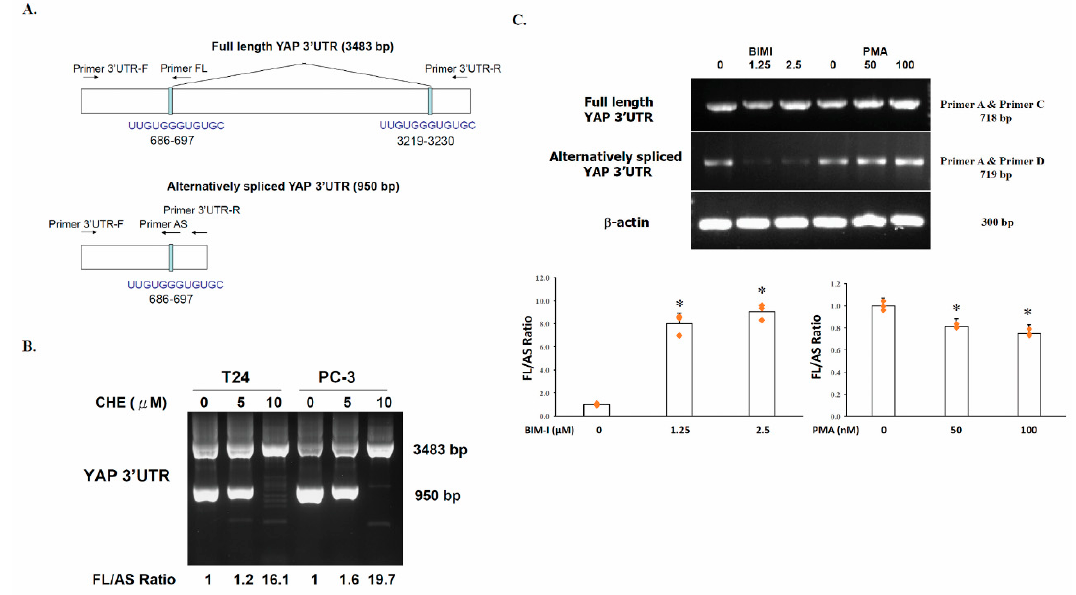
Figure 1. Inhibition of PKC activity reduces the YAP alternatively spliced YAP 3 ′ UTR mRNA. ( A ). Schematic presentation of the full-length (top) and alternatively spliced (bottom) isoforms of the YAP 3 ′ UTR. Arrows indicate primer positions for PCR amplification of YAP 3 ′ UTR isoforms. The alternatively spliced YAP 3 ′ UTR is generated by the splice deletion of base pairs between 697 and 3218. The locations of short direct repeat sequences are indicated. ( B ). T24 and PC-3 cells were incubated with chelerythrine chloride at the indicated concentrations. Twenty-four hours after incubation, the total RNA was harvested and the RT-PCR assay was performed. YAP 3 ′ UTR s were amplified by RT-PCR. The bands were scanned with a densitometer, and the ratios of the full length to alternatively spliced 3 ′ UTR were calculated. β -actin gene was used as an internal control for RNA quality and loading. ( C ). PC-3 cells were treated with increasing concentrations (0, 1.25, and 2.5 µM) of bisindolylmaleimides I (BIM-I) or PMA (0, 50, and 100 nM) for 24 h ( n = 3). Cells were lysed, and total RNA was used for RT-PCR using specific primers for full-length YAP 3 ′ UTR, alternatively spliced YAP 3 ′ UTR and β -actin. Significance was tested using one-way analysis of variance (ANOVA) with Holm–Sidak method post hoc test, where * p < 0.05 compared to the control.